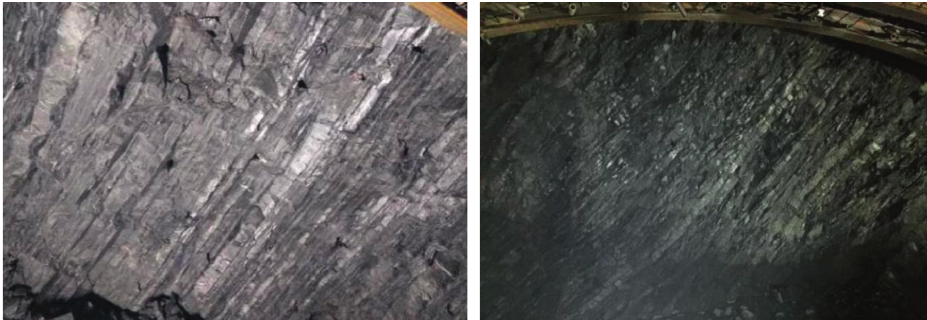
Figure 6: surrounding rock of the tunnel face.